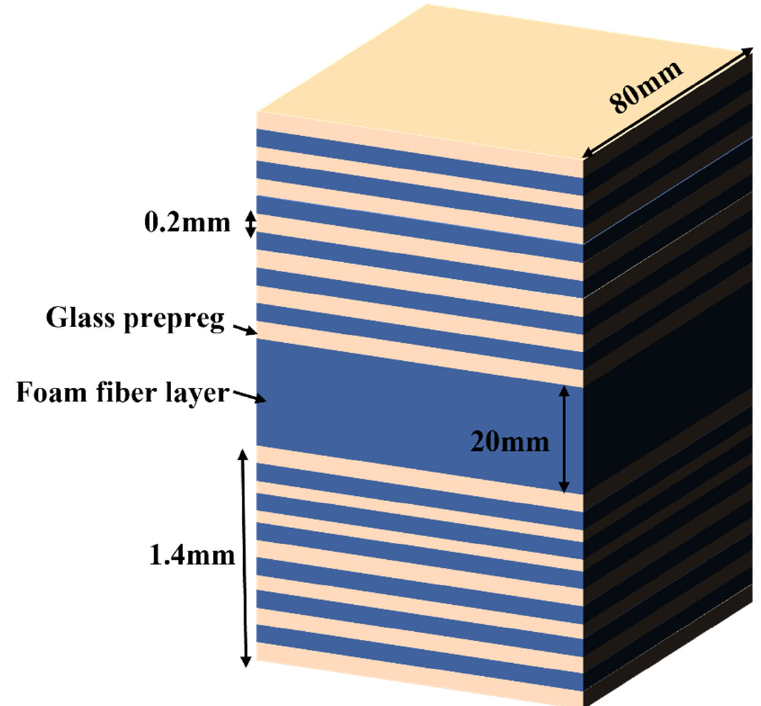
Figure 4. Design of the sandwich structure.